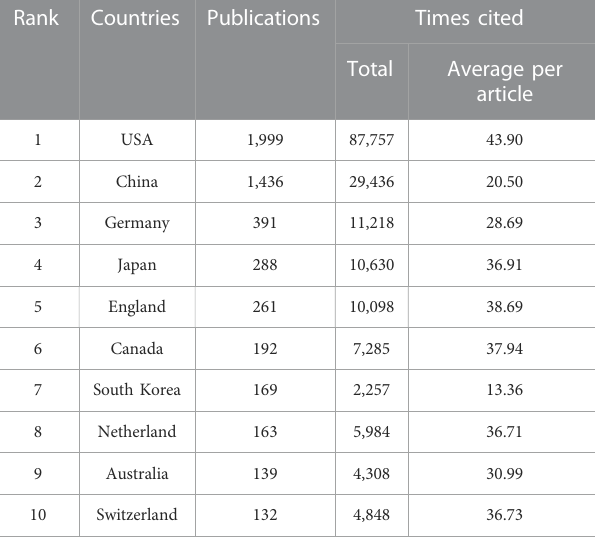
TABLE 2 The top 10 most active countries/regions related to CRISPR in cancer.